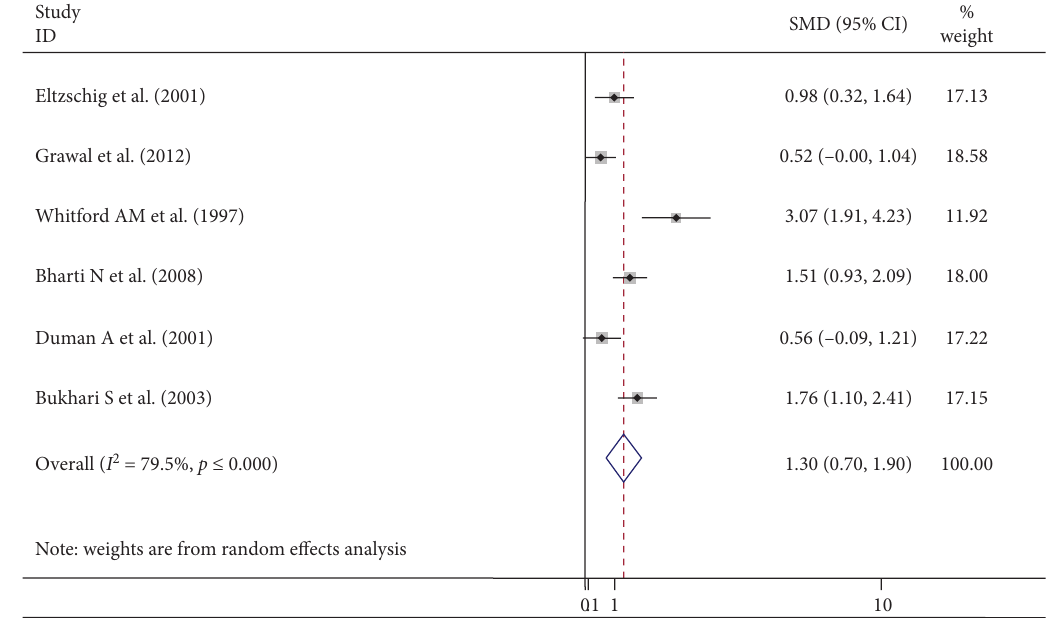
Figure 3: Meta-analysis of IOP after ETT intubation and LMA insertion.